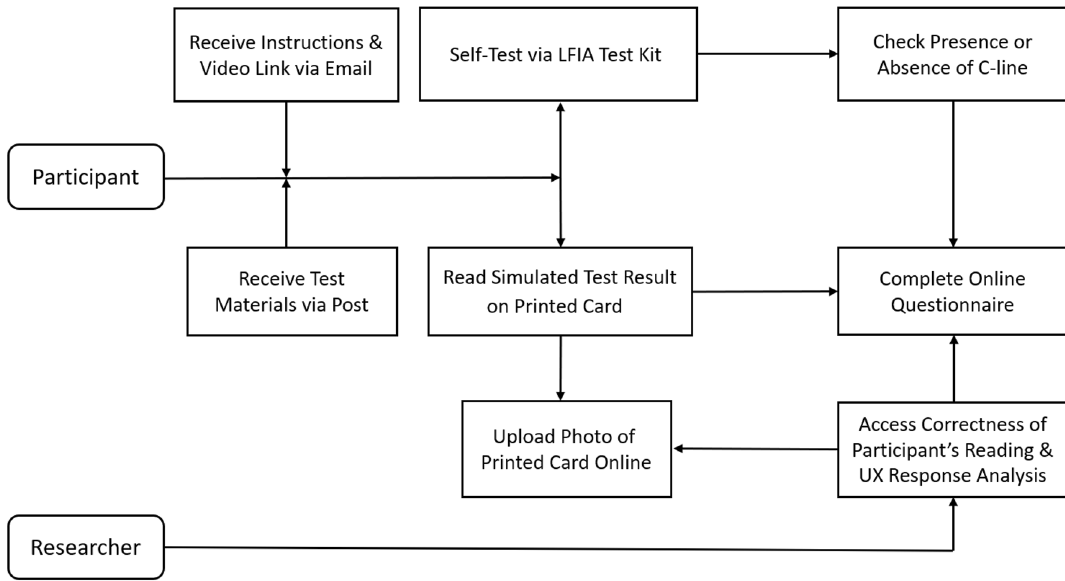
Figure 3. The diagram for the study